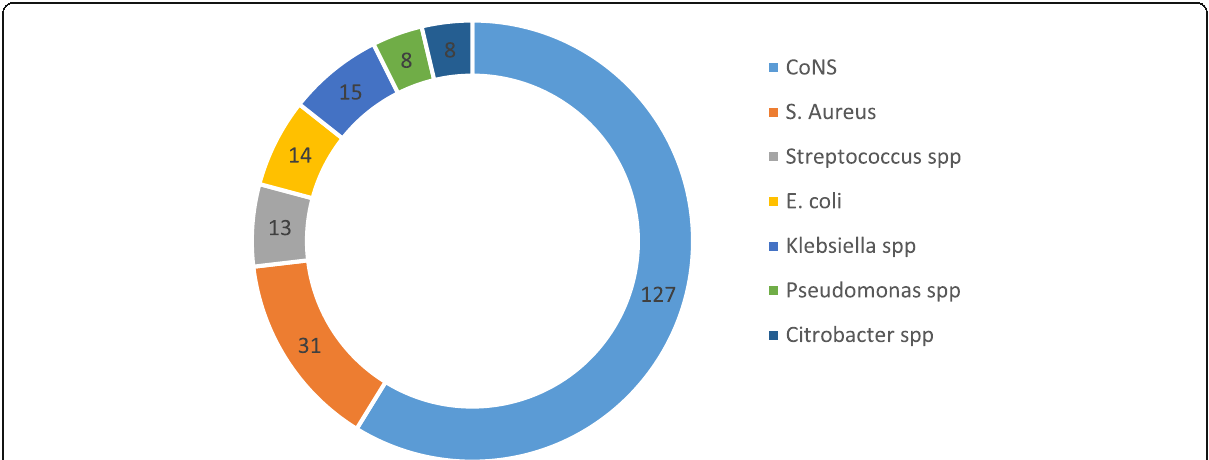
Fig. 2 Distribution of bacterial isolates from mobile phones of health professionals at Hiwot Fana Specialized University Hospital, Harar,